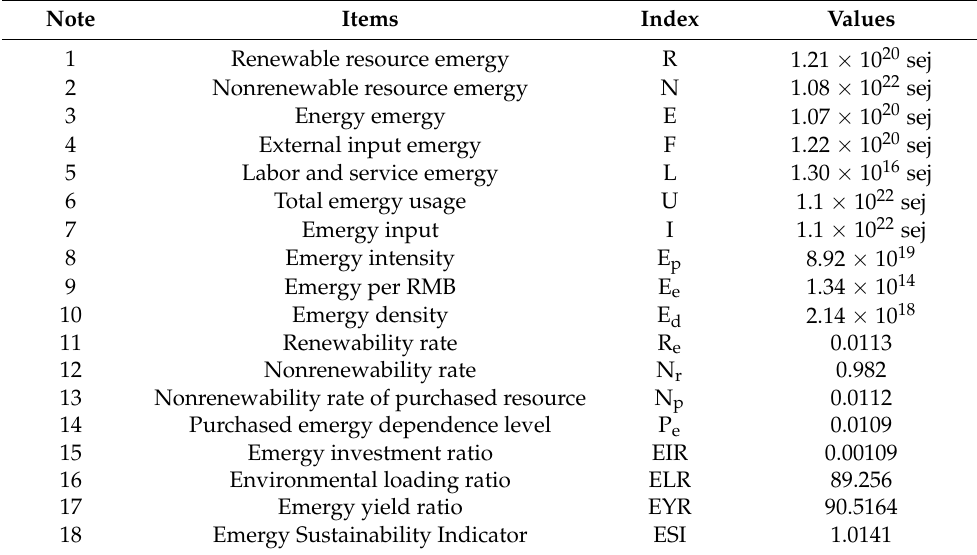
Table 7. Emergy indicators